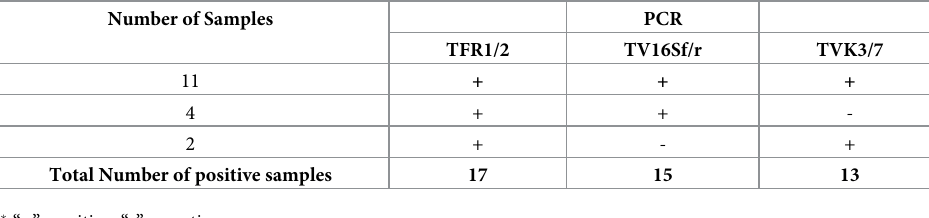
Table 3. Positivity using three different primer sets in PCR.